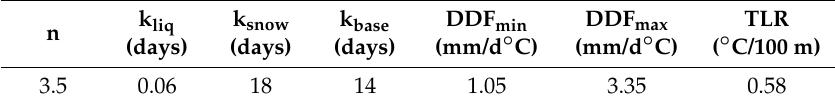
Table 3. Parameters after calibration and validation for Tremorgio basin. k liq is the runoff time parameter, k snow is the time parameter of snow, k base is the time parameter of groundwater, DDF min is the minimum value of degree-day factor, DDF max is the maximum value of degree-day factor, and TLR is the temperature lapse rate. k liq k snow n (days) (days)